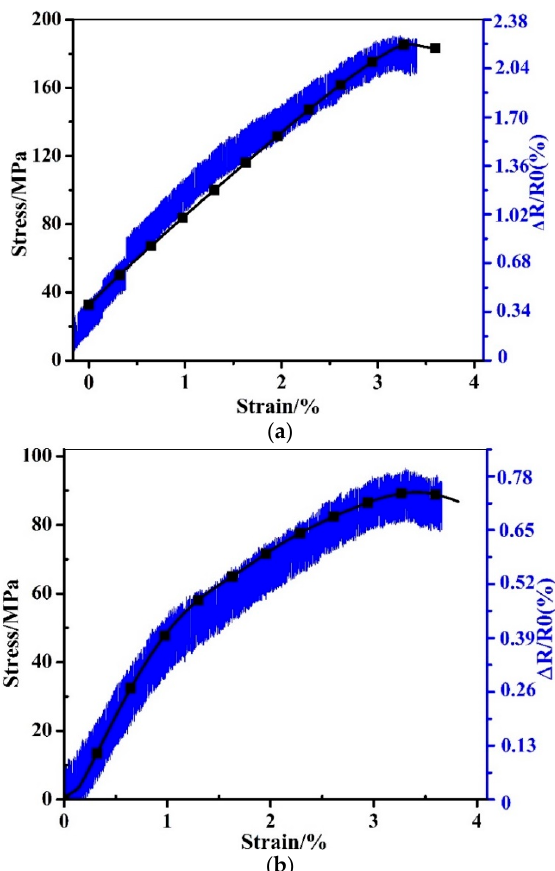
Table 2. The mechanical performance of the composites laminates before and after embedding the multi-walled carbon nanotube (MWCNT) sensors in different mechanical tests.